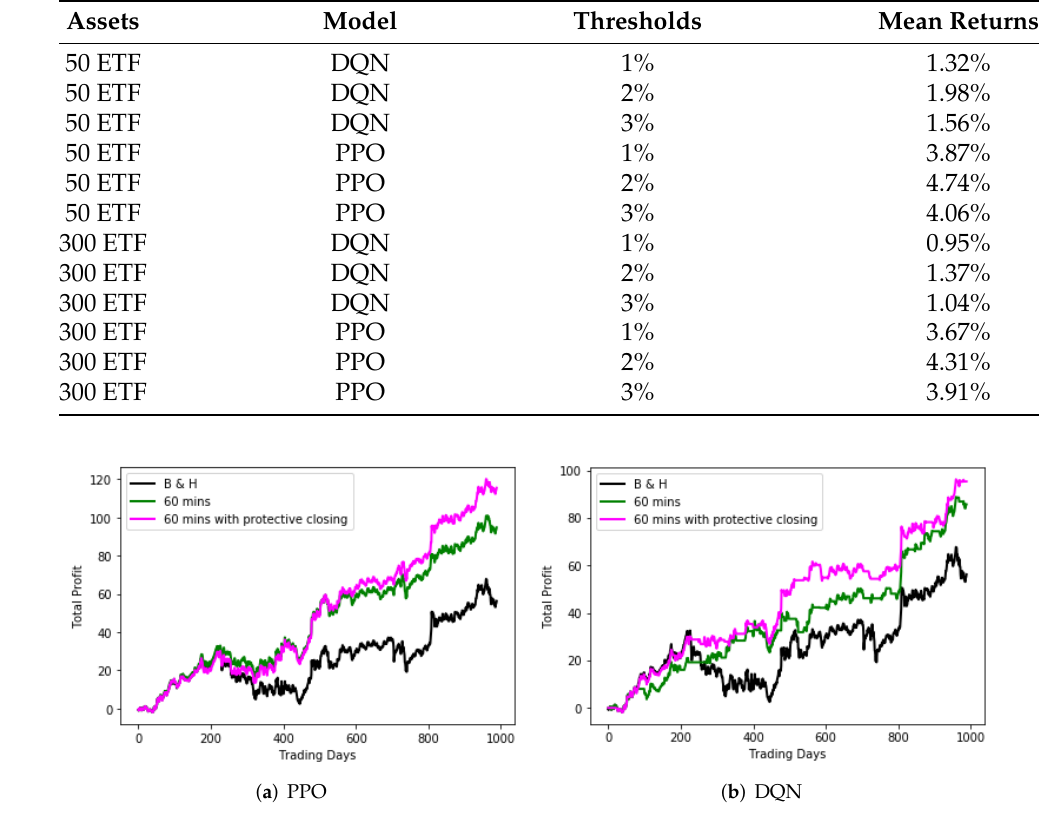
Figure 8. Trading performance on 50 ETF.